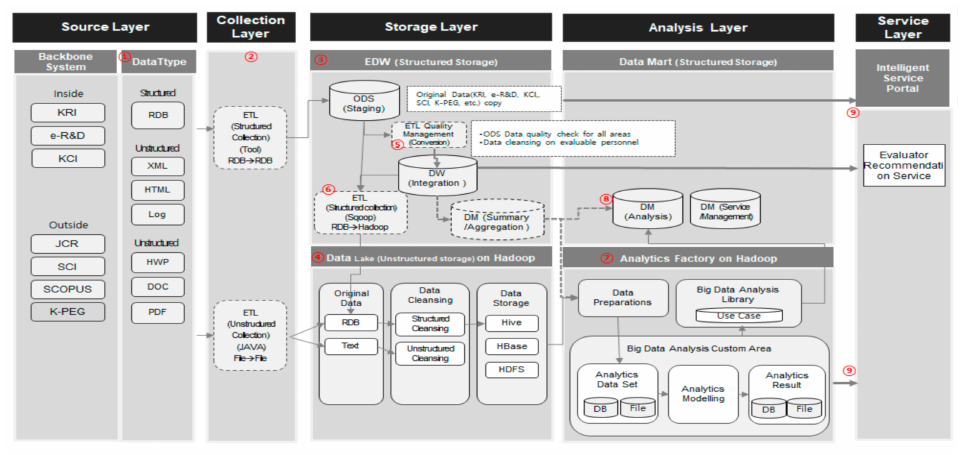
Figure 2. Big data platform